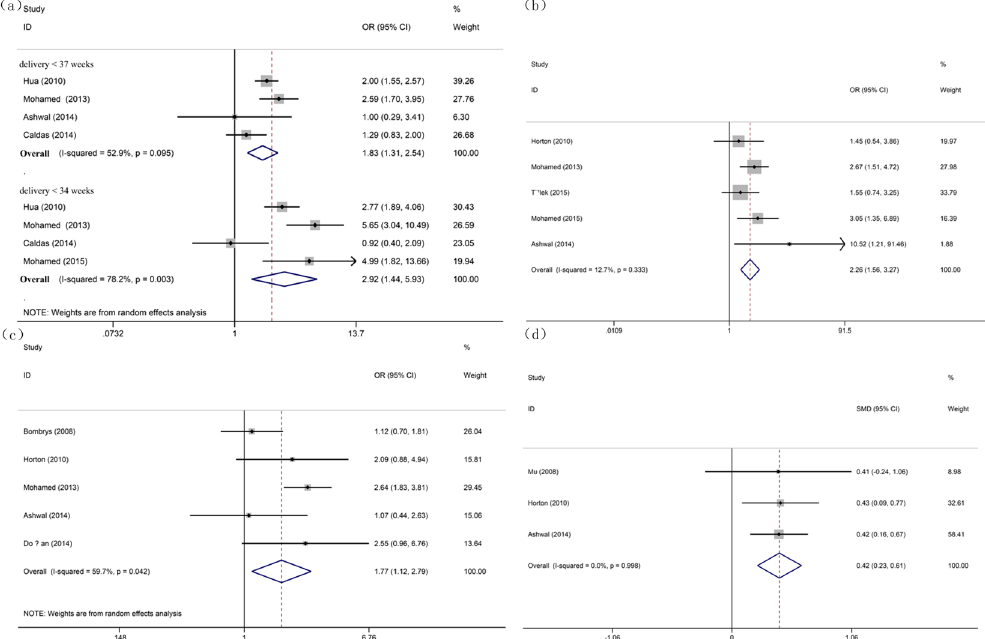
Figure 4. Forest plot of study assessing the association between iSUA and adverse neonatal outcomes: ( a ) neonates of delivery < 37 weeks and < 34 weeks; ( b ) CS due to fetal distress; ( c ) the rate of admitted to NICU and ( d ) the duration in NICU.